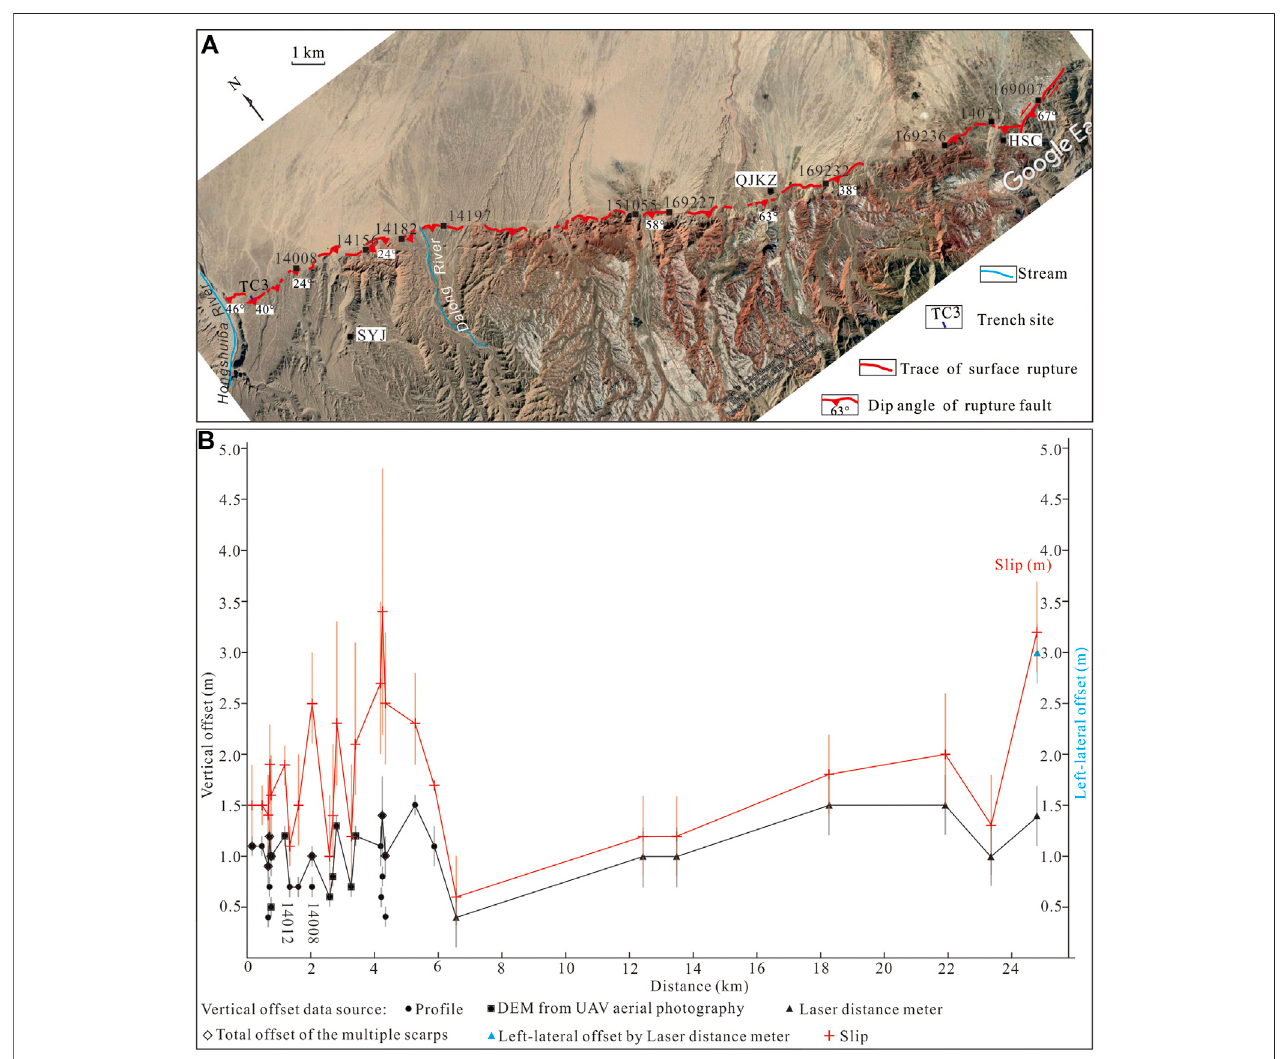
FIGURE10|(A) Mapofthe1609surfaceruptureinthewesternsegment.Placenames:SYJ,Shiyangjuan;DLH,DalongRiver;QJKZ,Qujiakouzi;HSC,Hongshan Village. (B) Offset and slip of the 1609 earthquake in the western segment.